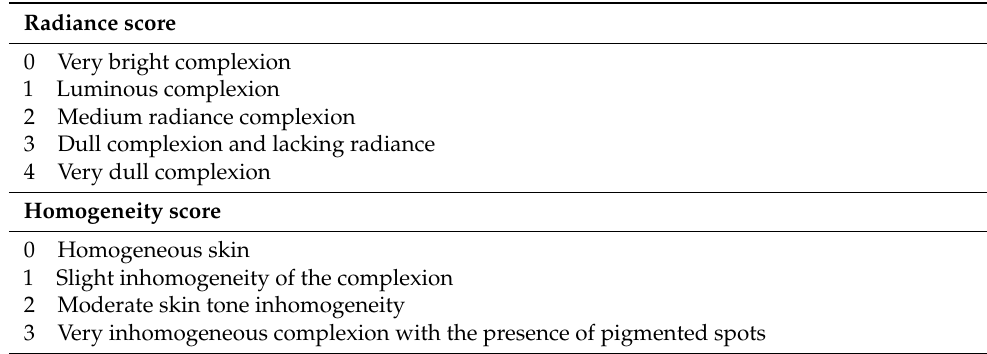
Table 1. Dermatological assessment of the clinical